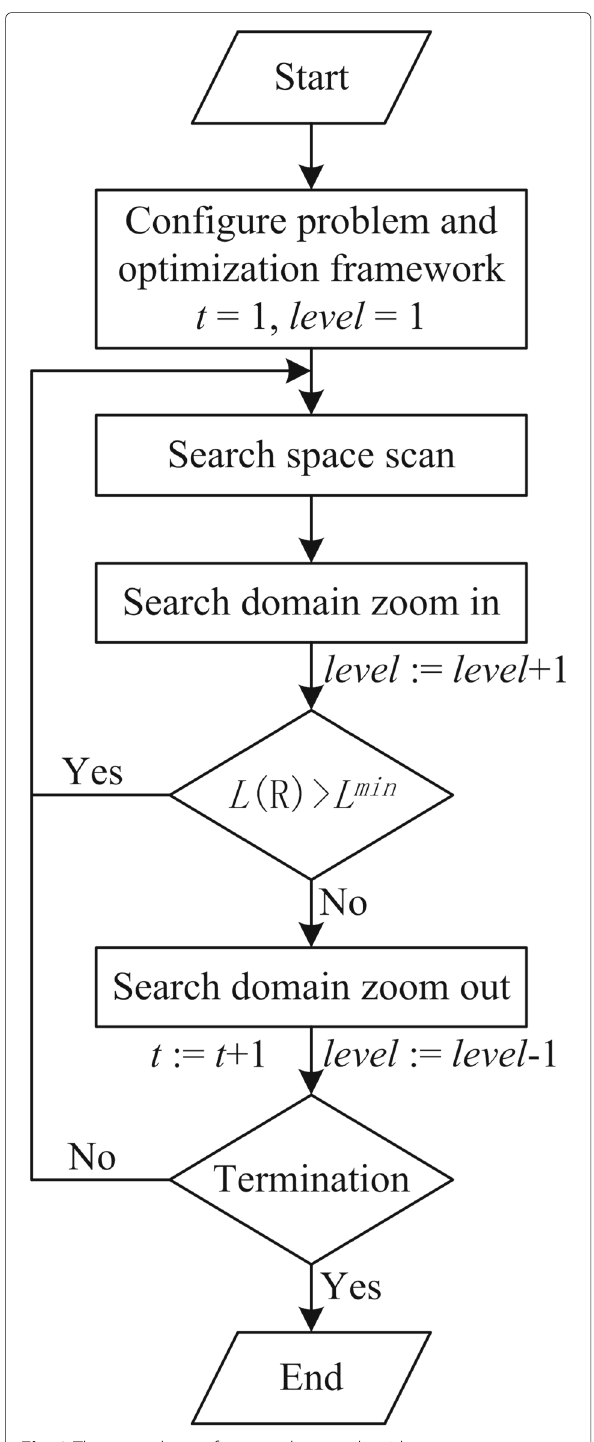
Fig. 2 The procedures of scan and zoom algorithm